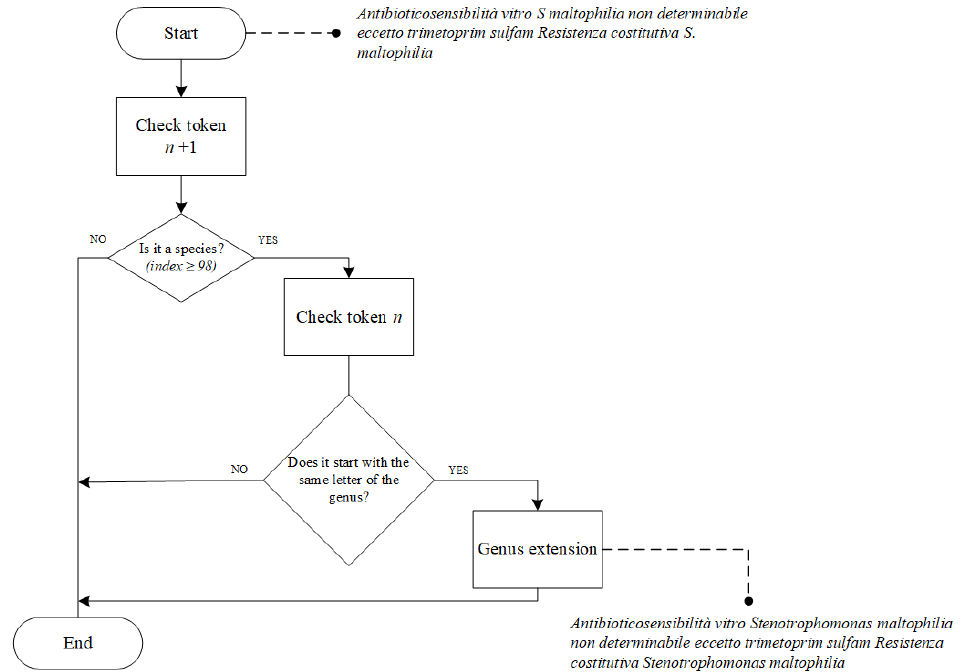
Figure 2. Genus extension decision flow. The figure also includes an example. In the upper part of the figure, there is a sentence already preprocessed but before the genus extension phase, whereas, in the lower part, we can see the extended version. First, the maltophilia species is identified, while “S” as the first letter of genus Stenotrophomonas is extended.